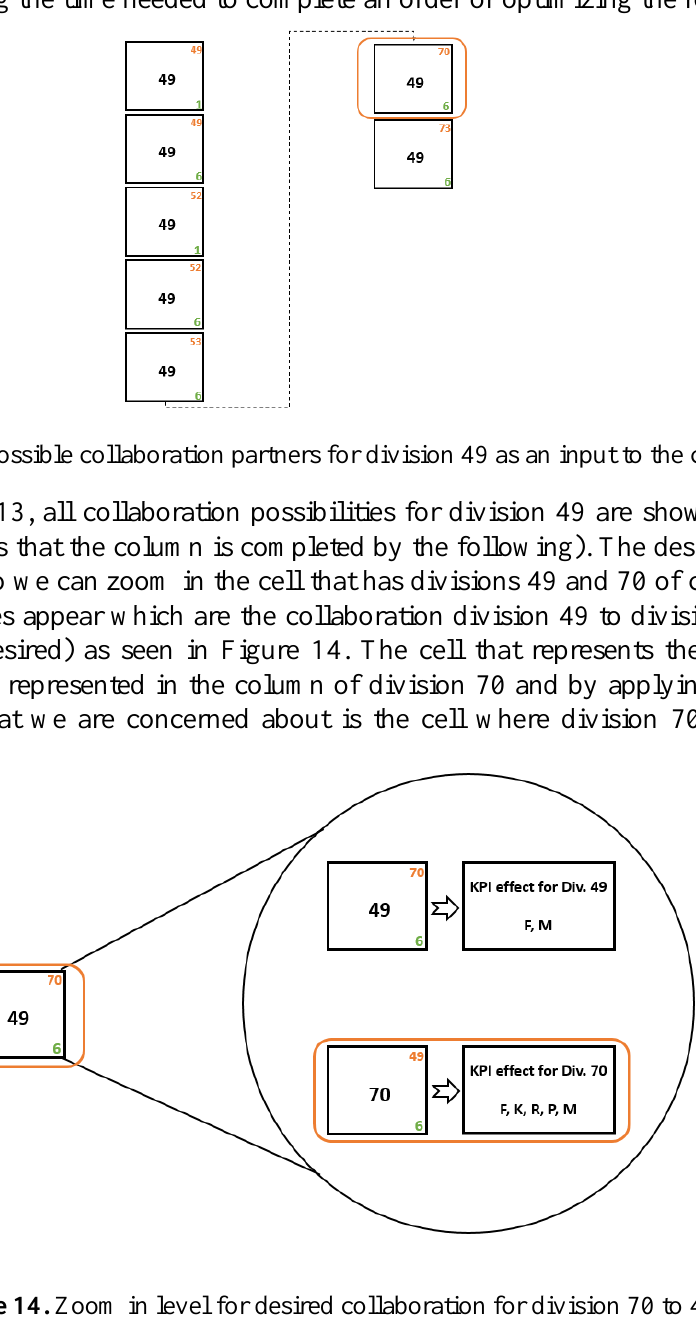
Figure 14. Zoom in level for desired collaboration for division 70 to